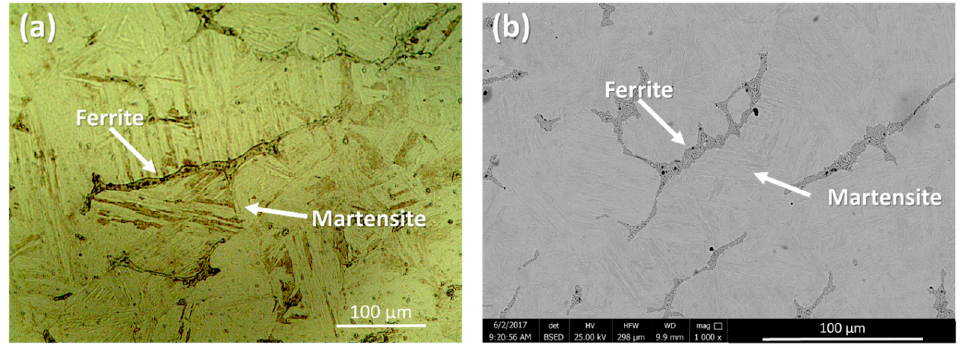
Figure 3. ( a ) Optical microscope image and ( b ) SEM micrograph of the 17 ‐ 4 PH stainless steel base material.